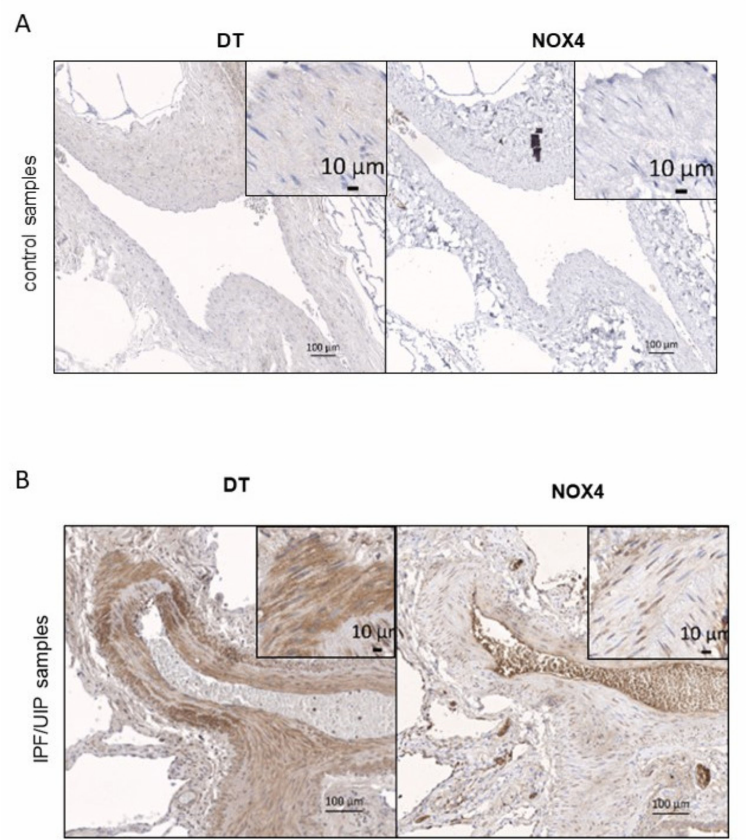
Figure 3. Representative images for DT ad NOX4 staining of blood vessel smooth muscle cells in the control ( A ) and IPF samples ( B ) of human patients are shown. Inset shows a 10 × higher magnification and depicts typical smooth muscle cell staining in these samples. DT and NOX4 staining are shown in